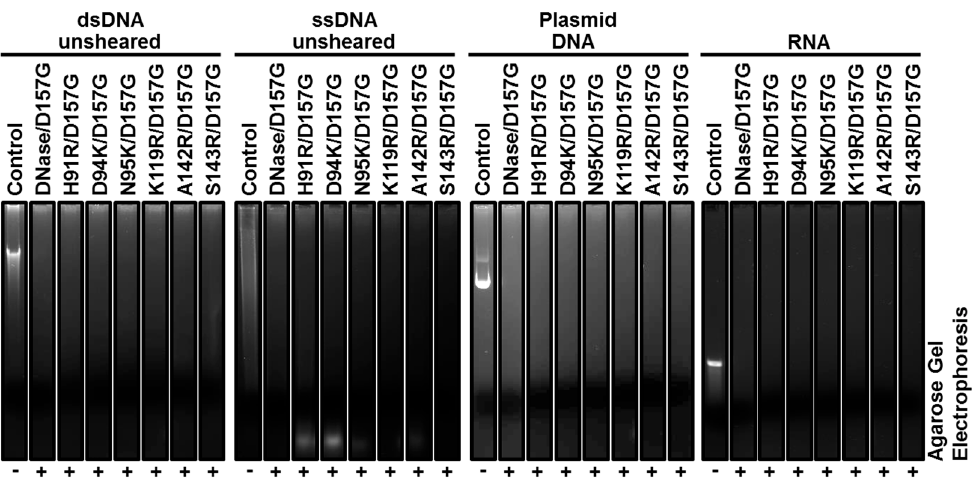
Figure A3. Substrate specificity of mutants with amino acid substitutions in the outer ring. All incubations were done for 1 h at 25 °C. “Control” indicates negative controls containing substrate but no enzyme in the reaction mixture.